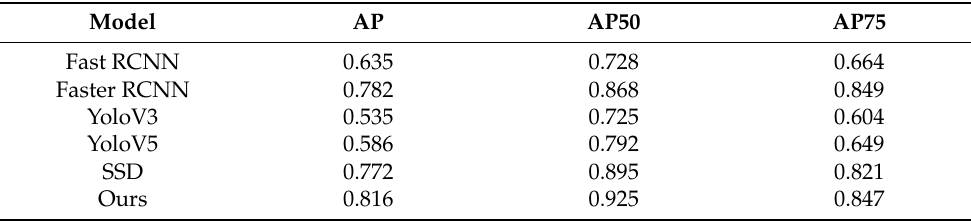
Table 3. The comparison results of AP between our proposed detector with the other state-of-the-art detection models.